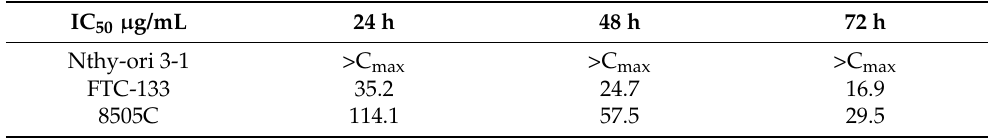
Table 1. Cytotoxic activity of broccoli sprout extract (BSE) against normal (Nthy-ori 3-1) and cancer (FTC-133 and 8505C) thyroid cells after 24, 48, and 72 h incubation expressed as IC 50 values ( µ g/mL). IC 50 µ